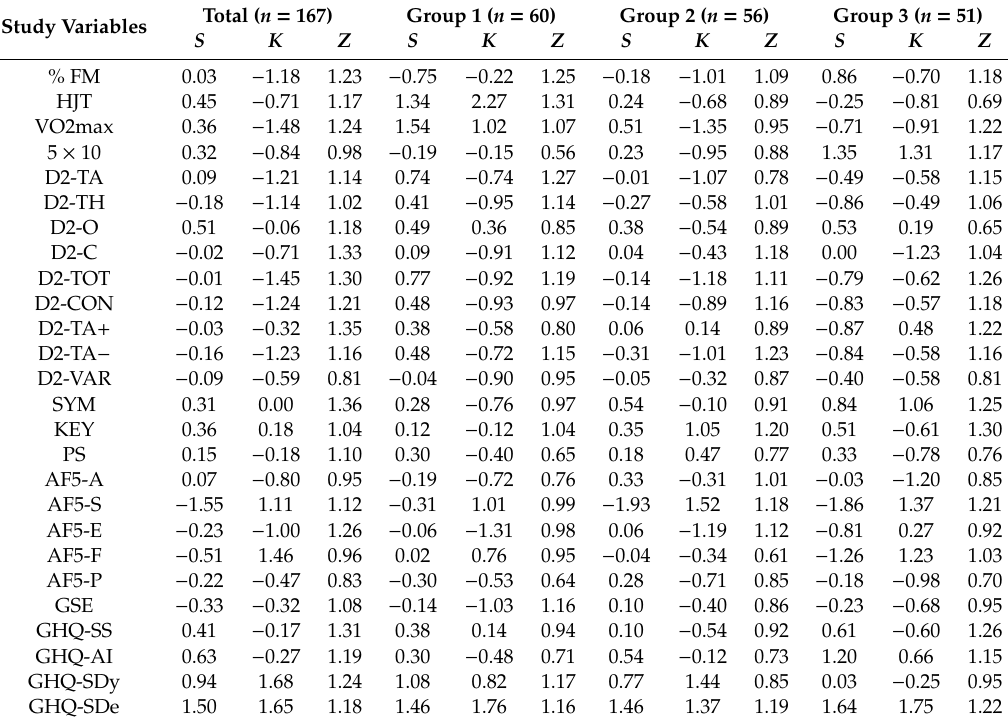
Table 2. Skewness, curtosis and Kolmogorov–Smirnov ( Z ) of study